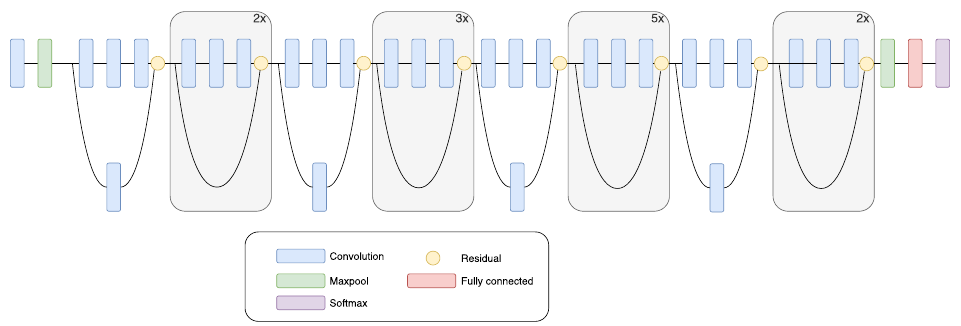
Figure 3. Schematic drawing of the ResNet CNN [51].